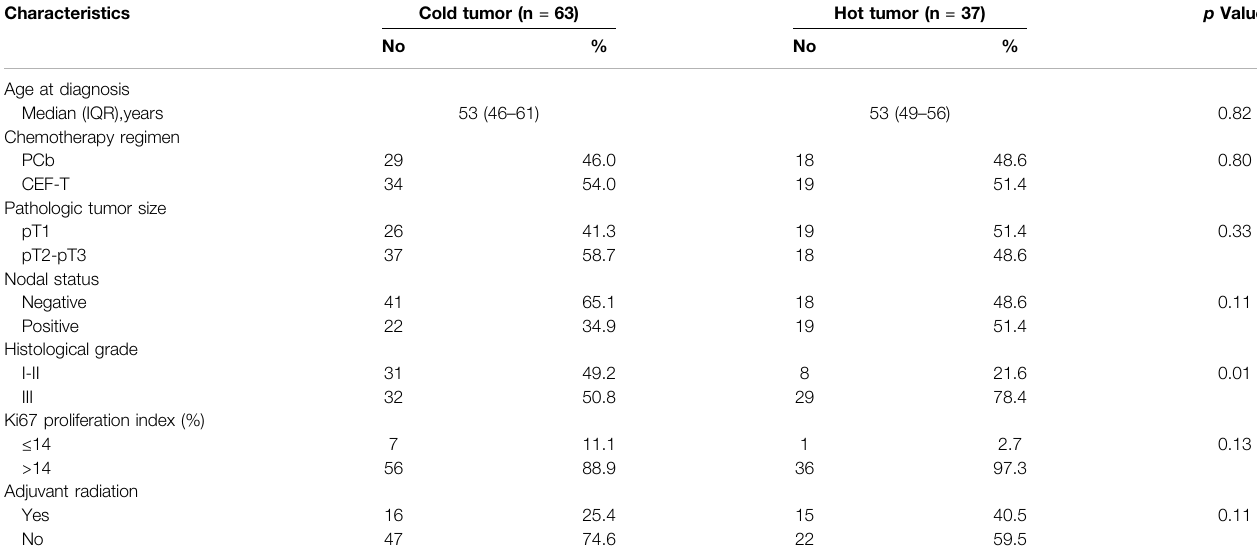
TABLE 1 | Clinicopathologic characteristics by microenvironment phenotypes.